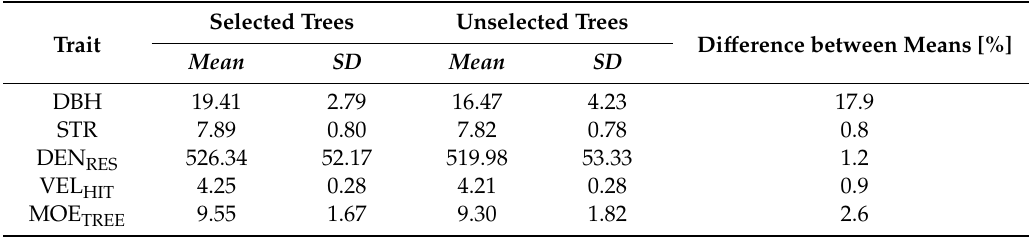
Table A1. Means and standard deviations ( SD ) for traits measured on standing trees selected and unselected for the sawmill